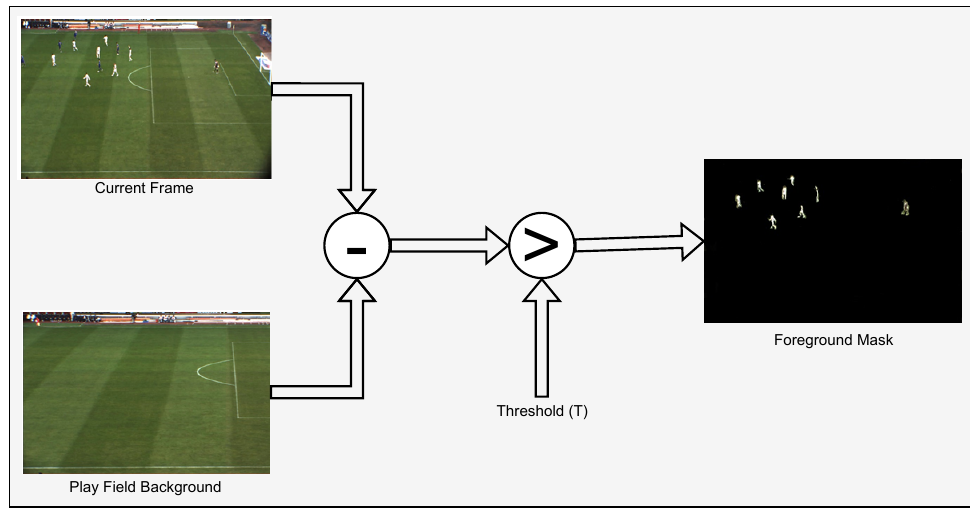
Figure 5. Background subtraction